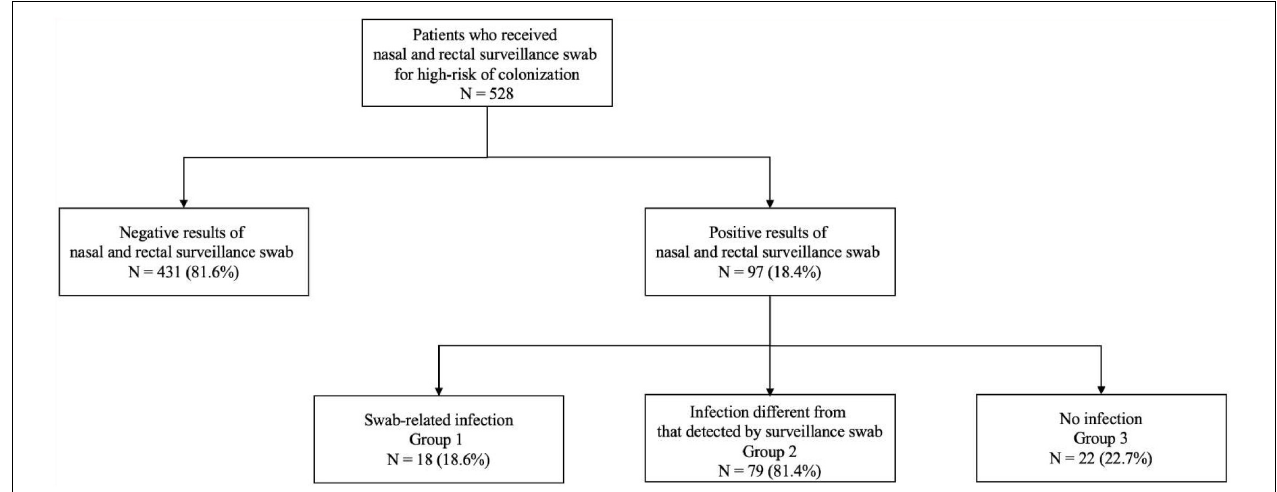
FIGURE 1 | Flowchart of the study